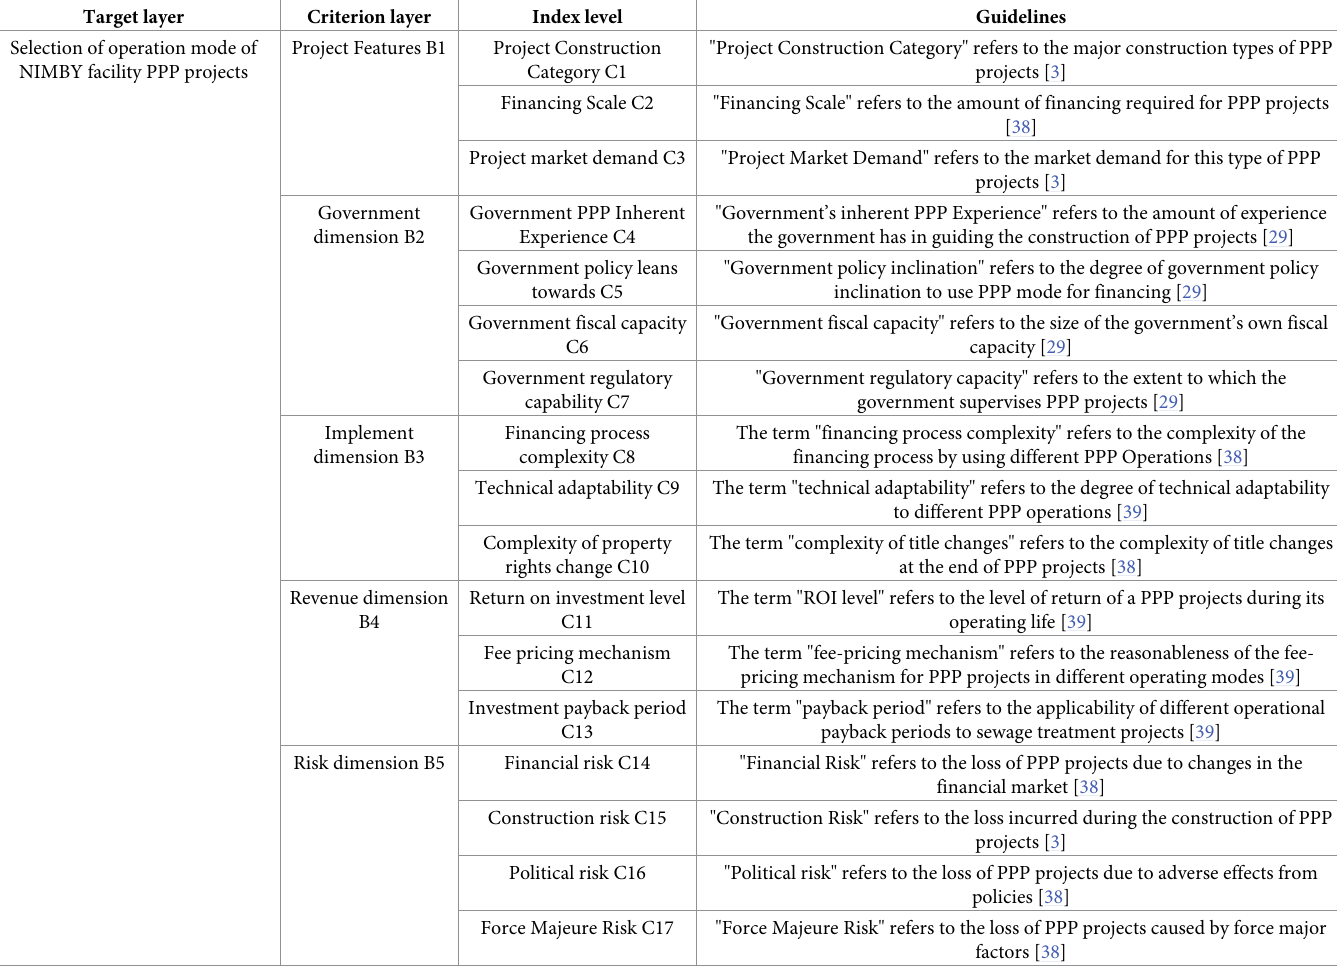
Table 2. Operation method measurement standard system of NIMBY facility PPP